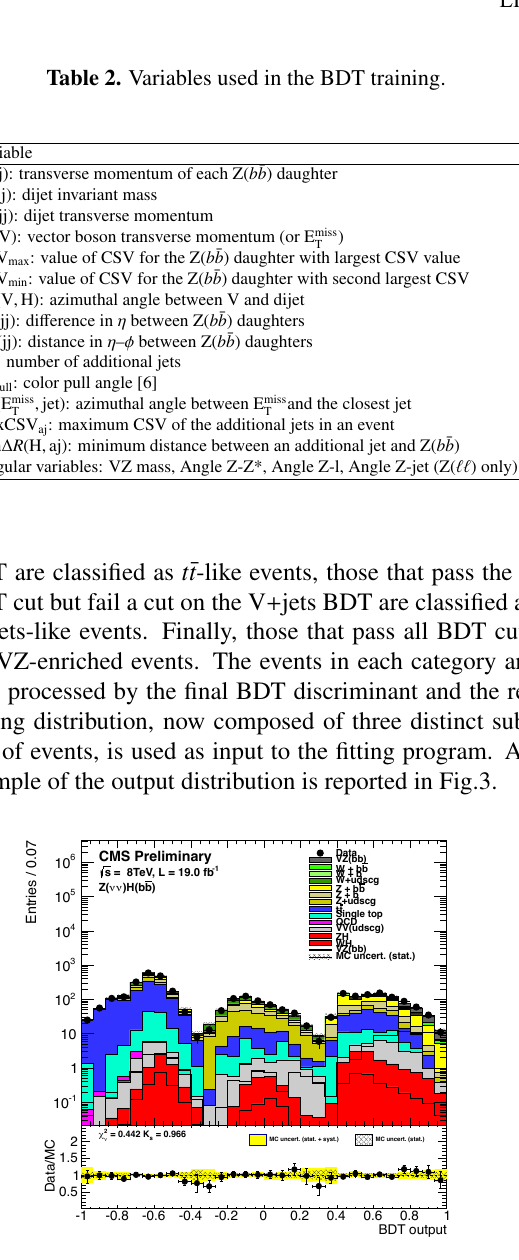
Figure 4. Weighted dijet invariant mass distribution, combined for all channels. For each channel, the relative weight of each p T (V) bin is obtained from the ratio of the expected number of signal events to the sum of expected signal and background